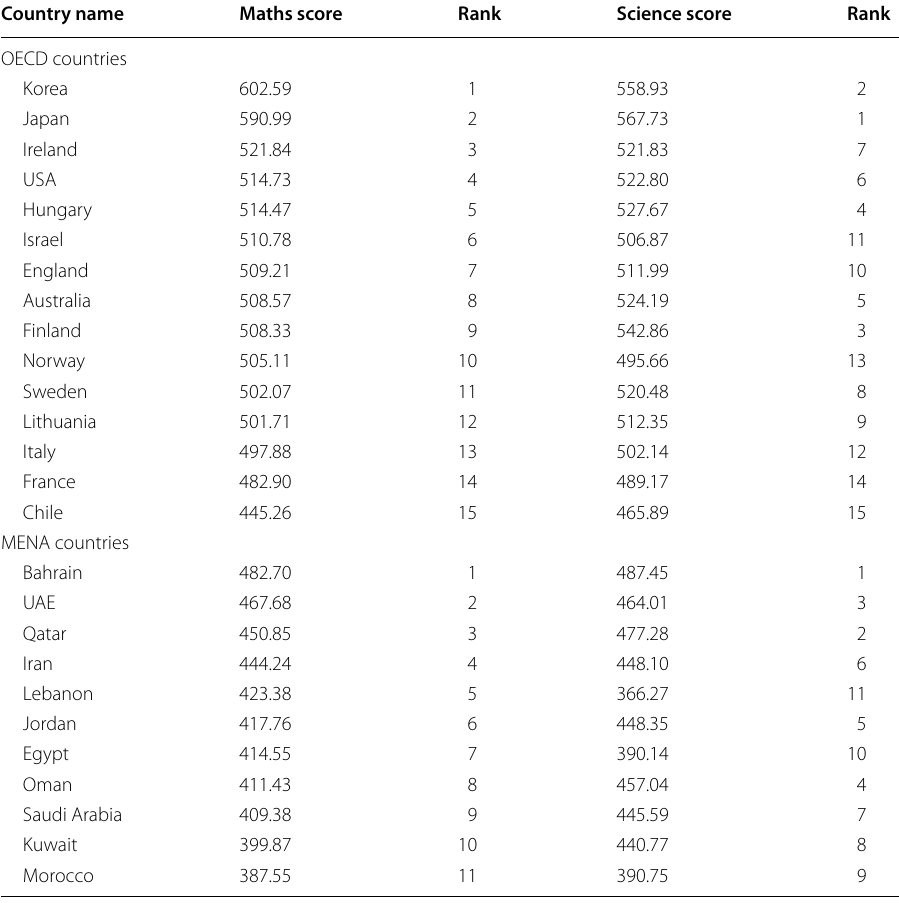
Scores are weighted average of students corresponding to actual sample size of country. International point of reference for comparison is 500